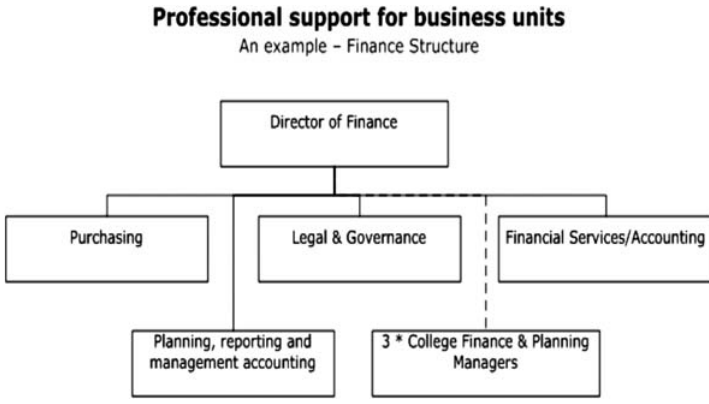
Figure 3. Secondary partnership through professional finance